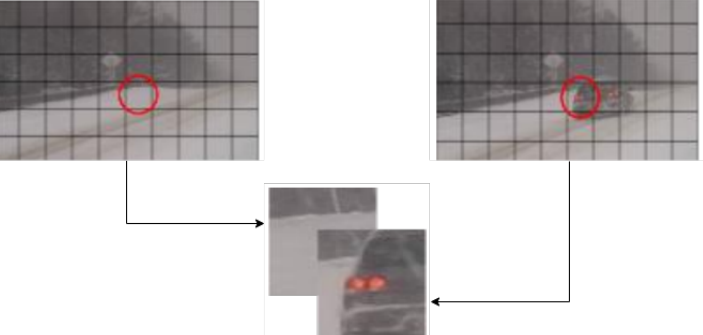
Figure 3. Representation of the sliding window and depth concatenation process on a reference image and a foreground